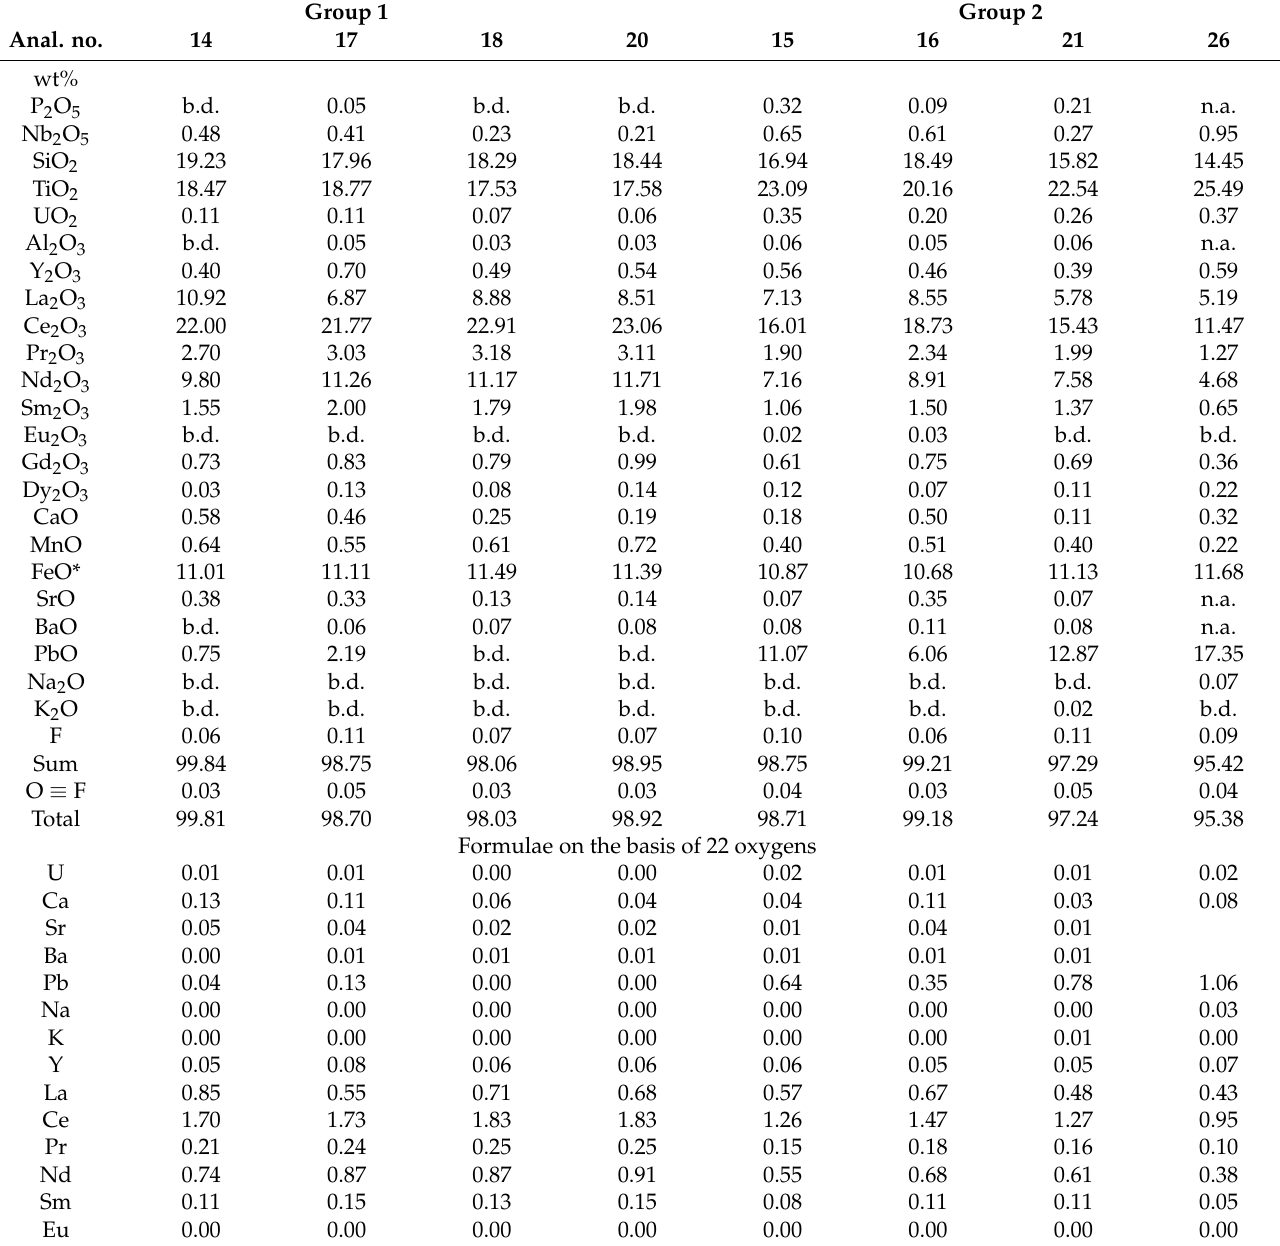
Table 1. Representative compositions of chevkinite-(Ce) and partly altered chevkinite. Group 1 Group